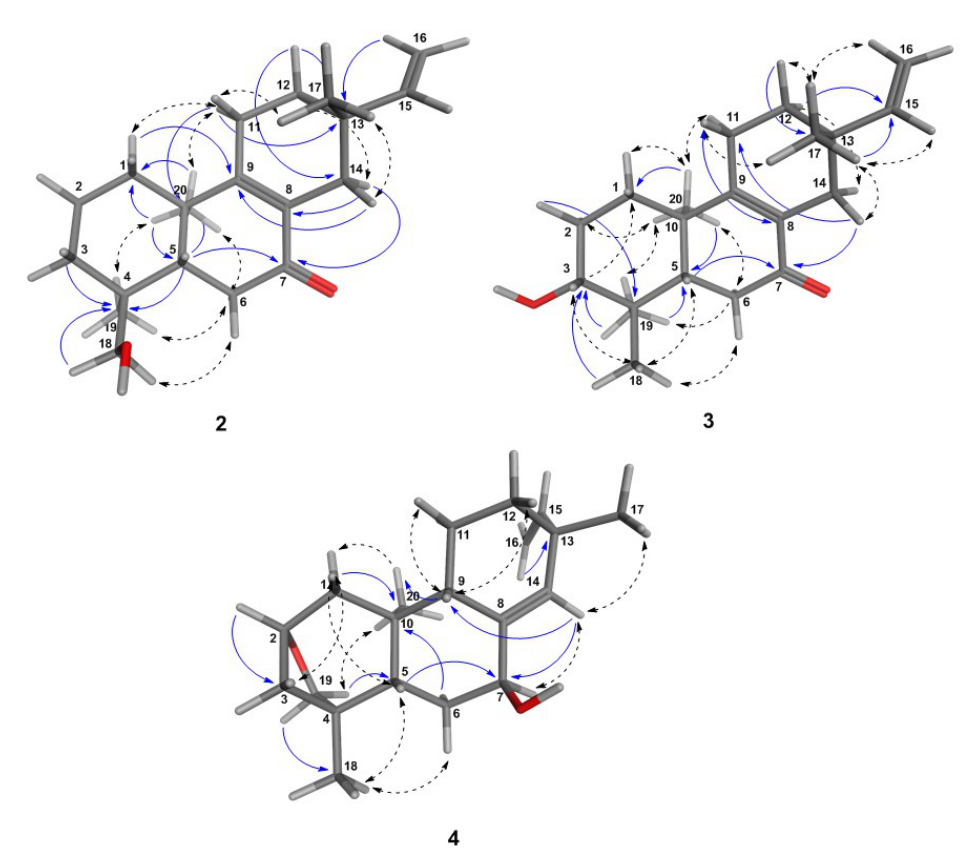
Figure 2. 3D-structures of the most energetically-favorable conformers for the ent -pimaranes 2 – 4 obtained after a low mode molecular dynamics (LMD) conformation search. Distances ( ≤ 3.0 Å) between the protons in the molecular model were in agreement with the experimental NOE effects, as shown by the NOESY correlations (dashed arrows). HMBC key correlations are also shown (blue